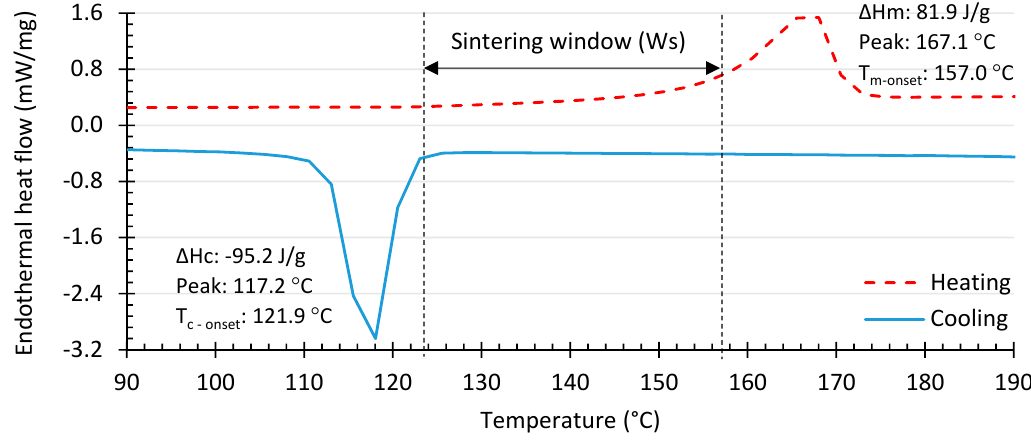
Figure 3. DSC thermograph for the neat polypropylene.